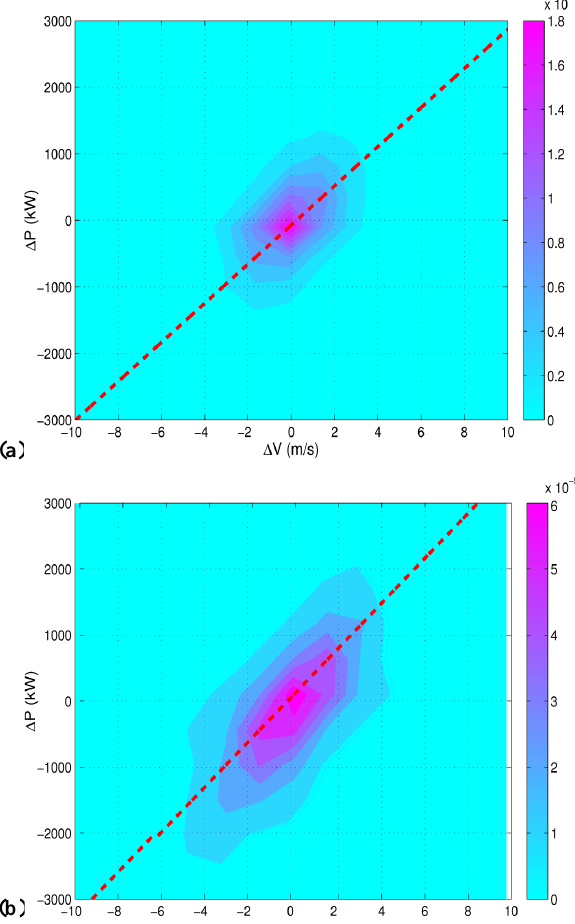
Fig. 10. The joint distribution P (1v,1P) for wind speed fluctua- tions 1v and output power 1P , for (a) 1t = 10 4 s and (b) 1t = 10 5